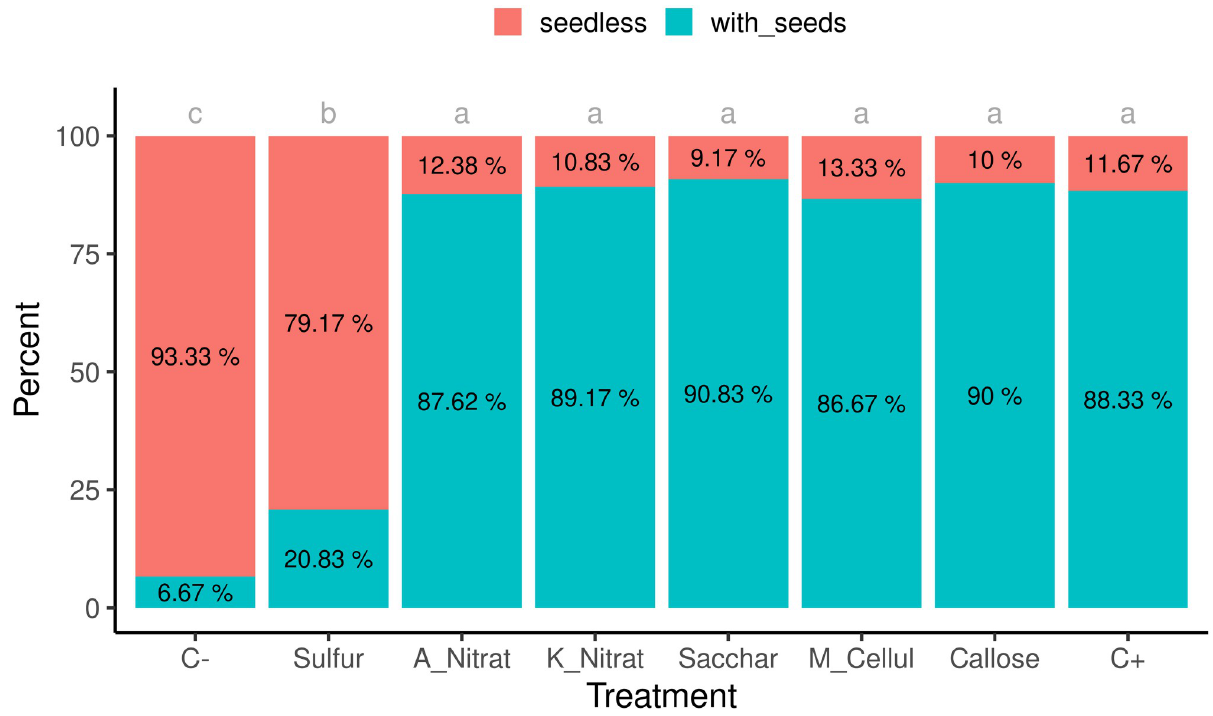
Fig 2. Percentage of seeded and seedless fruit per treatment. Blue (with seeds) indicates the fruit with one seed or more; red (seedless) denotes seedless fruit. Different gray letters represent statistically significant differences in the chi-square according to the Fisher test with Holm’s correction post hoc test (p-value = 5e-04). Treatments are noted as: C-, negative control; Sulfur; A_Nitrat, ammonium nitrate; K_Nitrat, potassium nitrate; Sacchar, saccharose; M_Cellul, methyl cellulose; Callose; C+, Positive control. The total number of fruit per treatment was 120, except for ammonium nitrate with